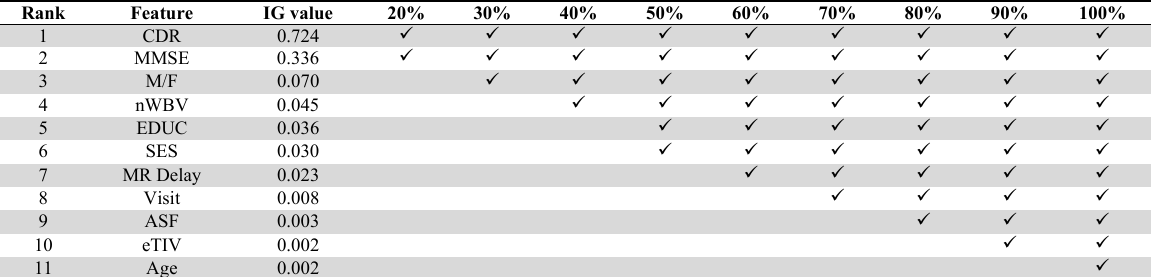
Feature Ranking and selection according to Information Gain. The  means that the feature has been selected by the threshold mentioned in the column header Rank